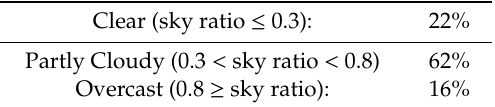
Table 1. Frequency of occurrence of the different sky types for Dammam area. Clear (sky ratio ≤ 0.3): 22% Partly Cloudy (0.3 < sky ratio < 0.8) 62% Overcast (0.8 ≥ sky ratio): 16%